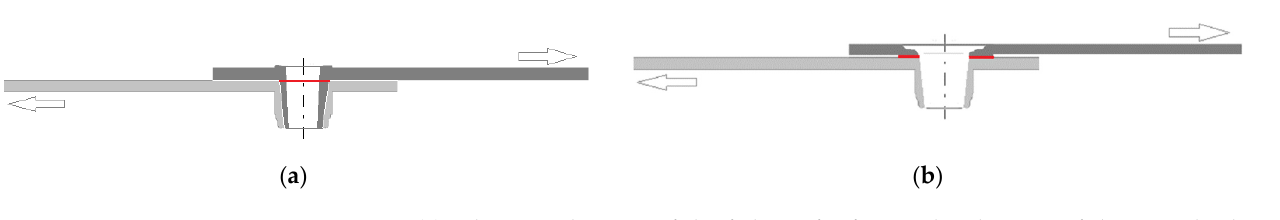
Figure 13. ( a ) Schematic diagram of the failure of a fit joint by shearing of the inner bushing, ( b ) Schematic diagram of friction joint failure. The shear plane is marked in red. The arrows indicate the direction of the load.